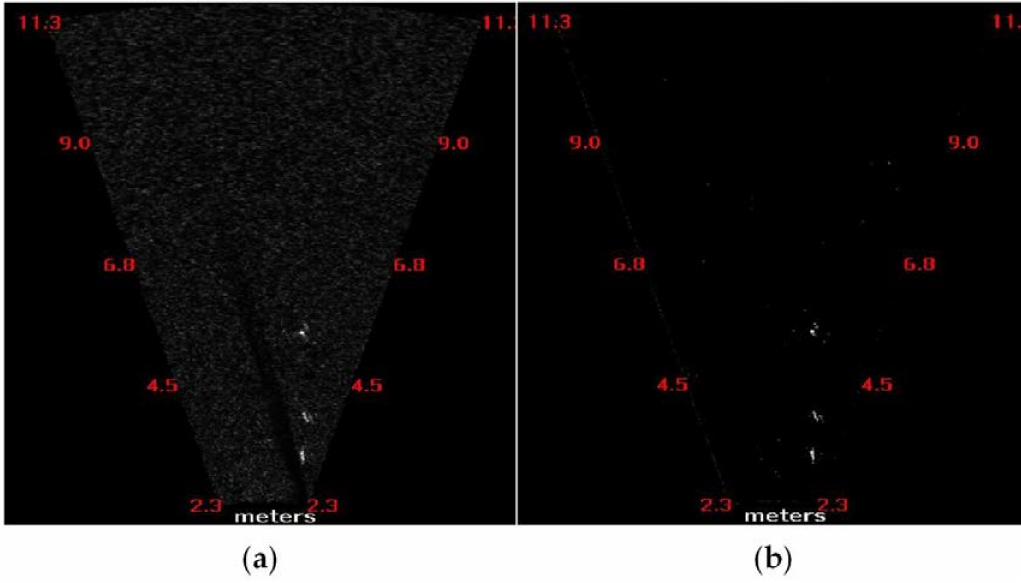
Figure 2. Target extraction with the proposed method. ( a ) Raw image and ( b ) image after background elimination. The bright regions in ( b ) are the